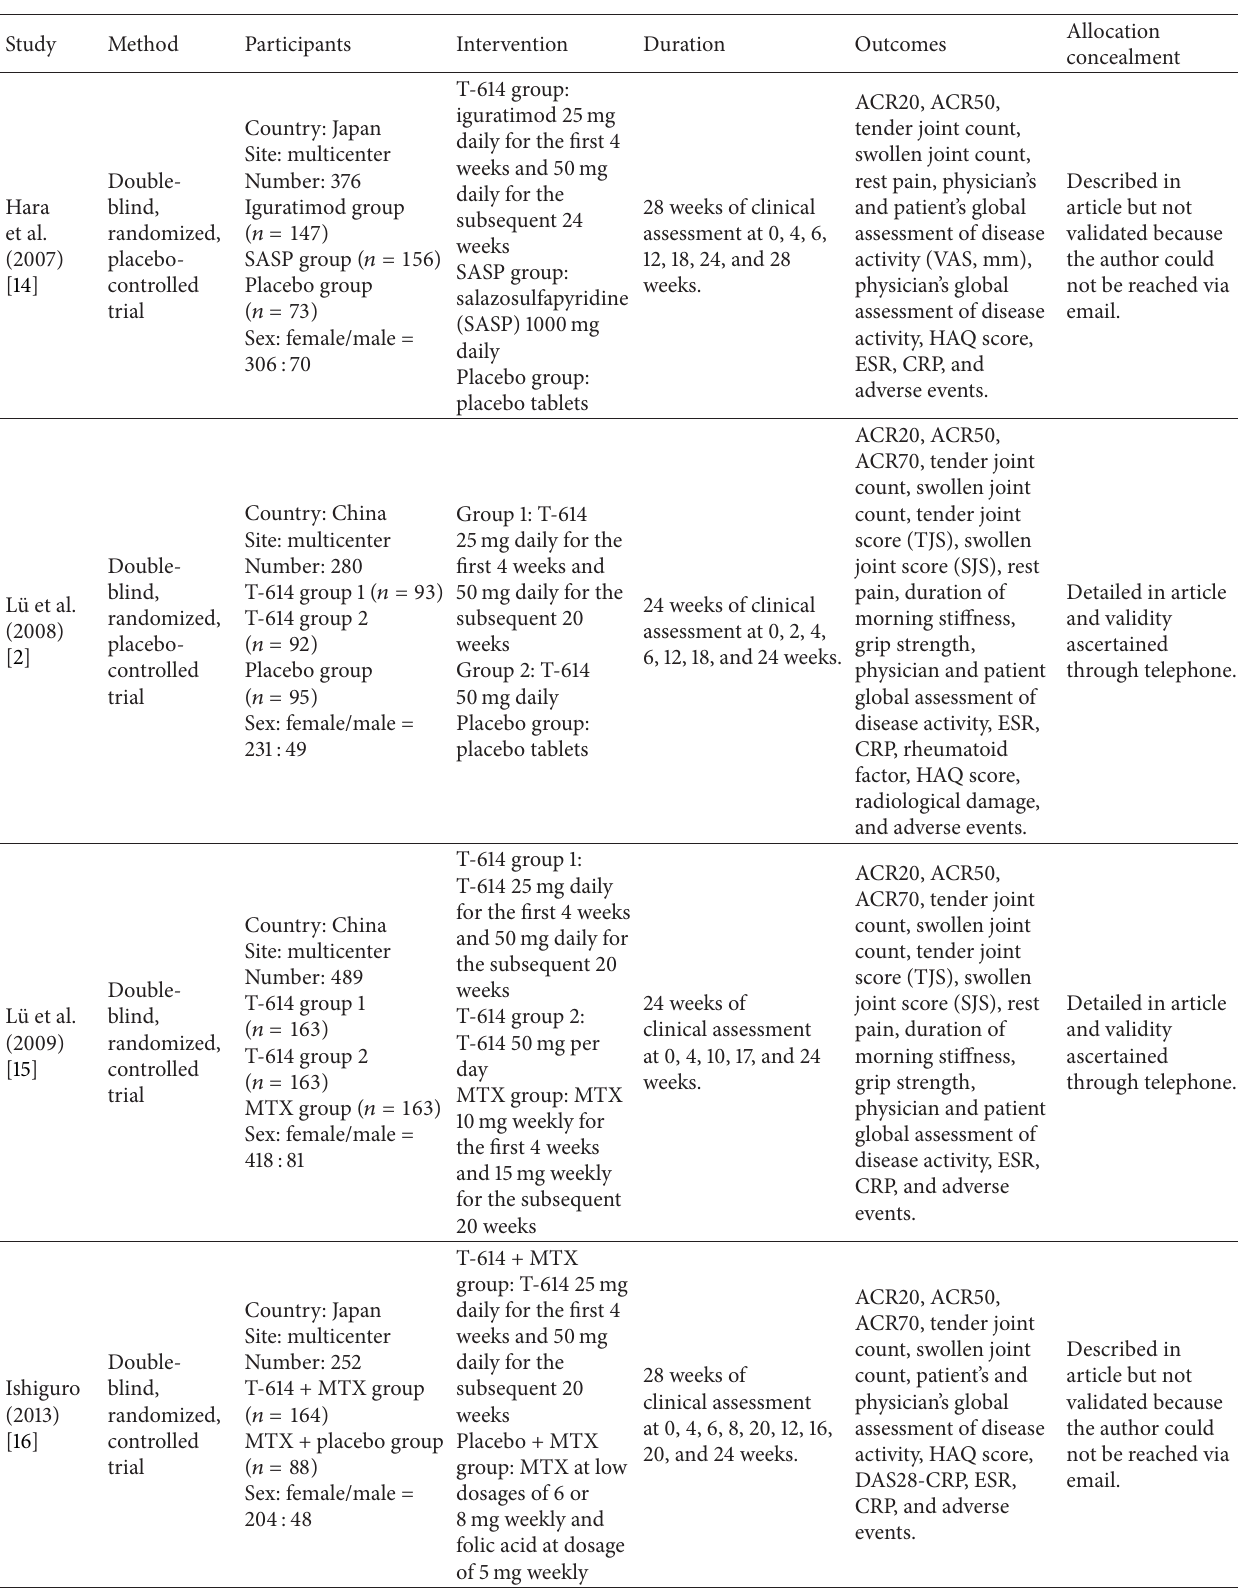
Table 1: Characteristics of the included studies with iguratimod (T-614) for rheumatoid arthritis.